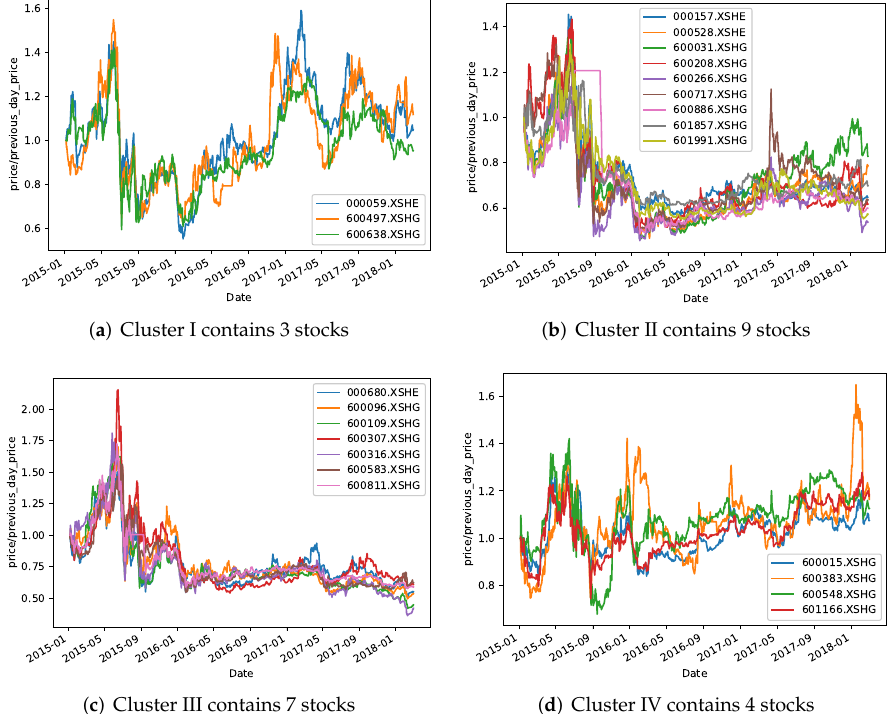
Figure 8. Randomly selected groups from CSI 300 based on TCN-Deep